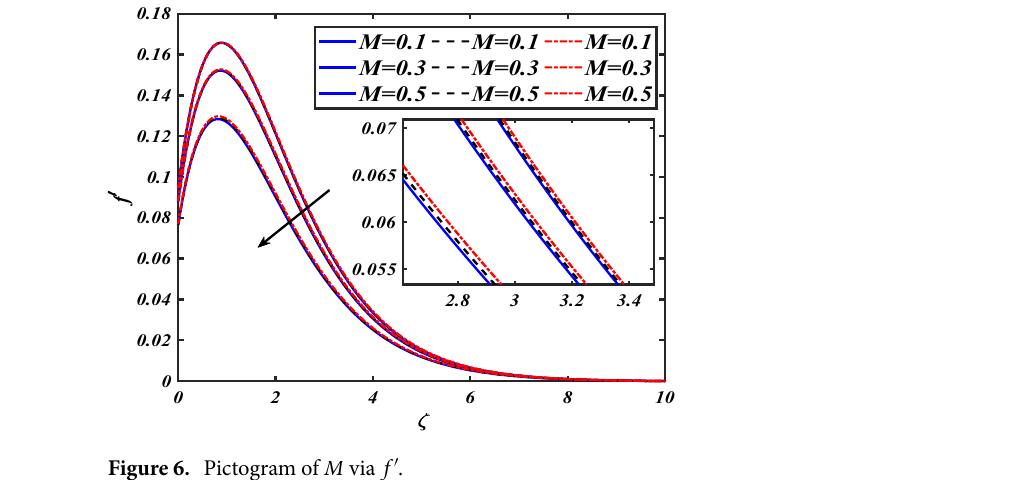
Figure 6. Pictogram of M via f ′ .